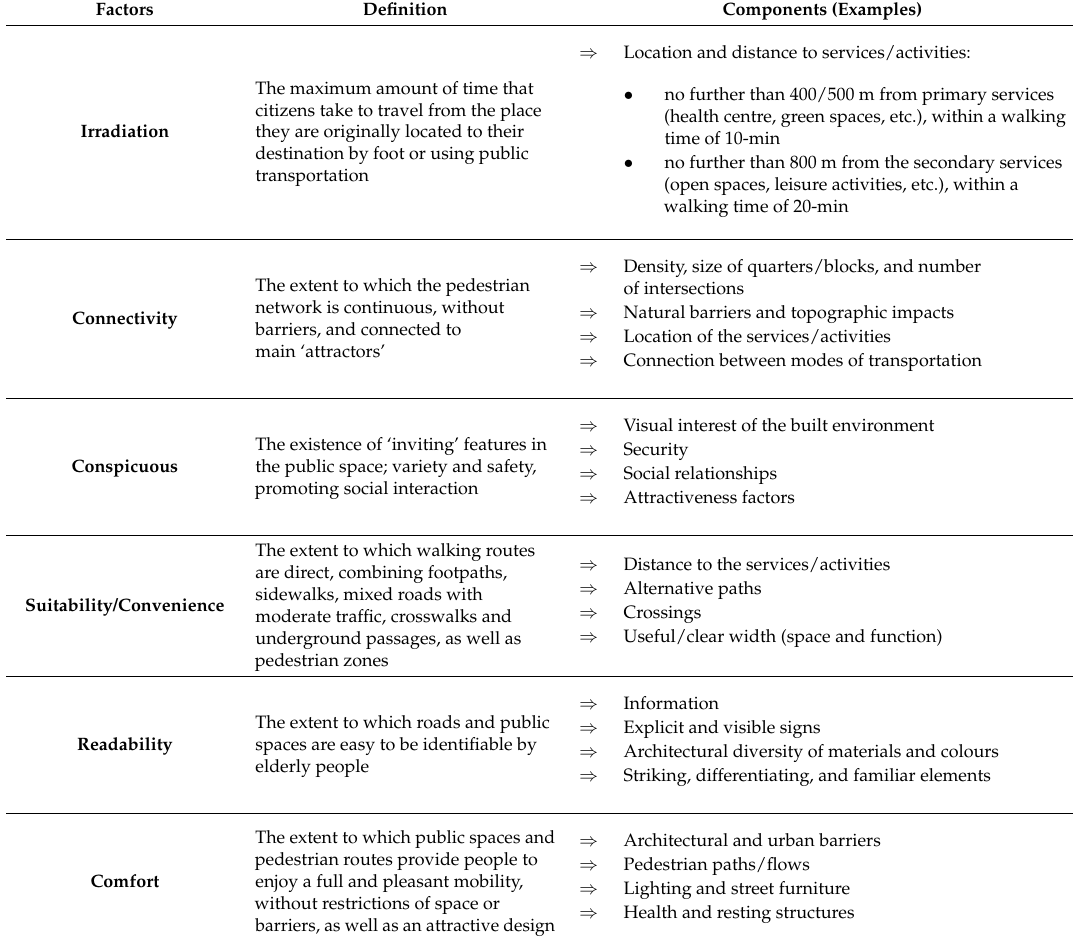
Table 1. Factors of the built environment (Aveiro, Portugal